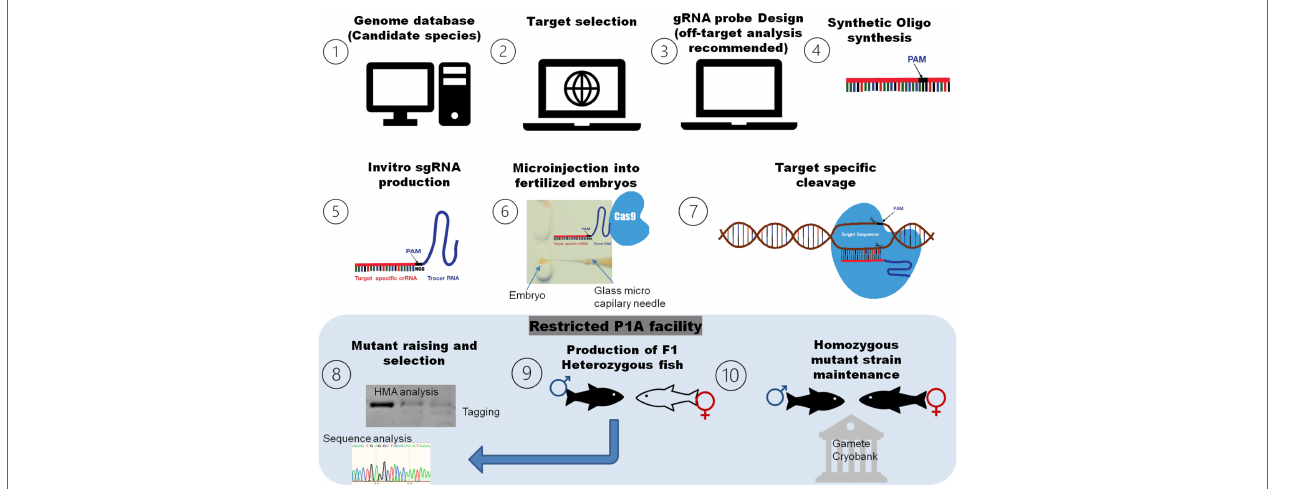
FIGURE 2 | A simple roadmap of general methodology for CRIPSR/Cas genome editing in aquaculture and fisheries. The target gene has to be selected after searching the genome database of candidate species. The sgRNA has to be designed with the help of sgRNA-designing tools, and then, the sgRNA oligo has to be synthesized. For target-specific cleavage, the sgRNA and cas9 mixture needs to be delivered to the newly fertilized embryo at a one-cell stage by microinjection or similar methods. The final step is the assessing the genome-editing results and application stage that includes mutagenesis analysis, the selection of mutants, crossing with wild population and production of a specific mutant line, the evaluation of CRISPR-induced mutation associated phenotyp(s), and the establishment of new varieties with improved values in